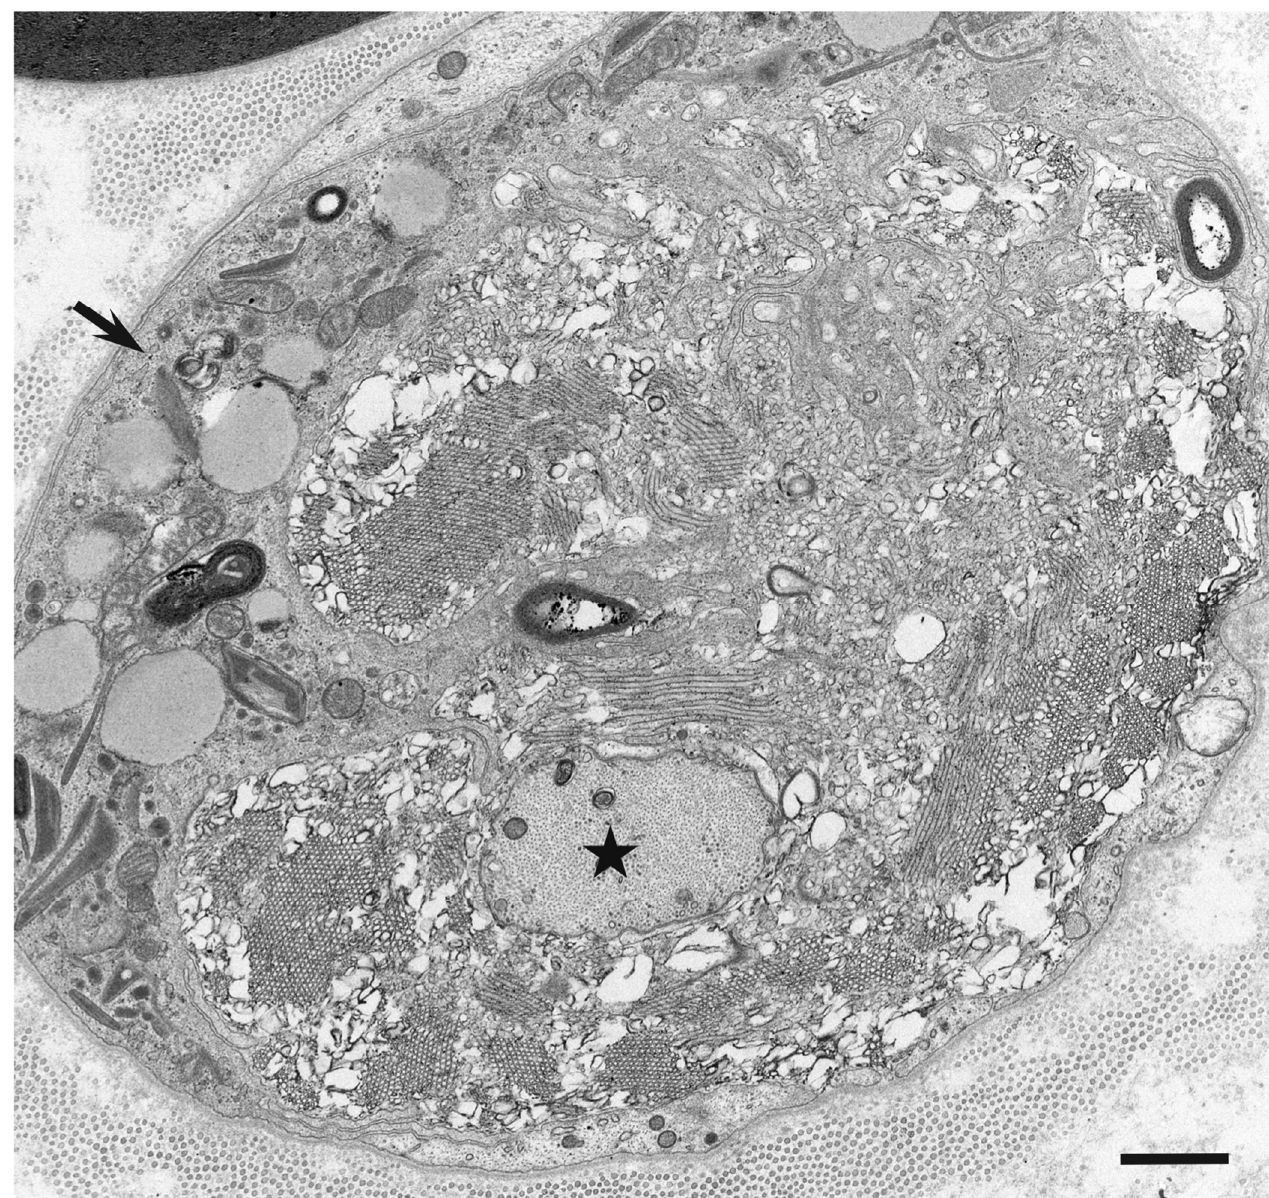
Figure 5. A demyelinated axon. A cross section of a sural nerve biopsy specimen obtained from a patient with AIDP. A demyelinated axon indicated by an asterisk is surrounded by a space filled with vesicular dissolution of the myelin. The cytoplasm of a macrophage indicated by an arrow is also within the basement membrane tube. Uranyl acetate and lead citrate staining. Scale bar = 1 m.